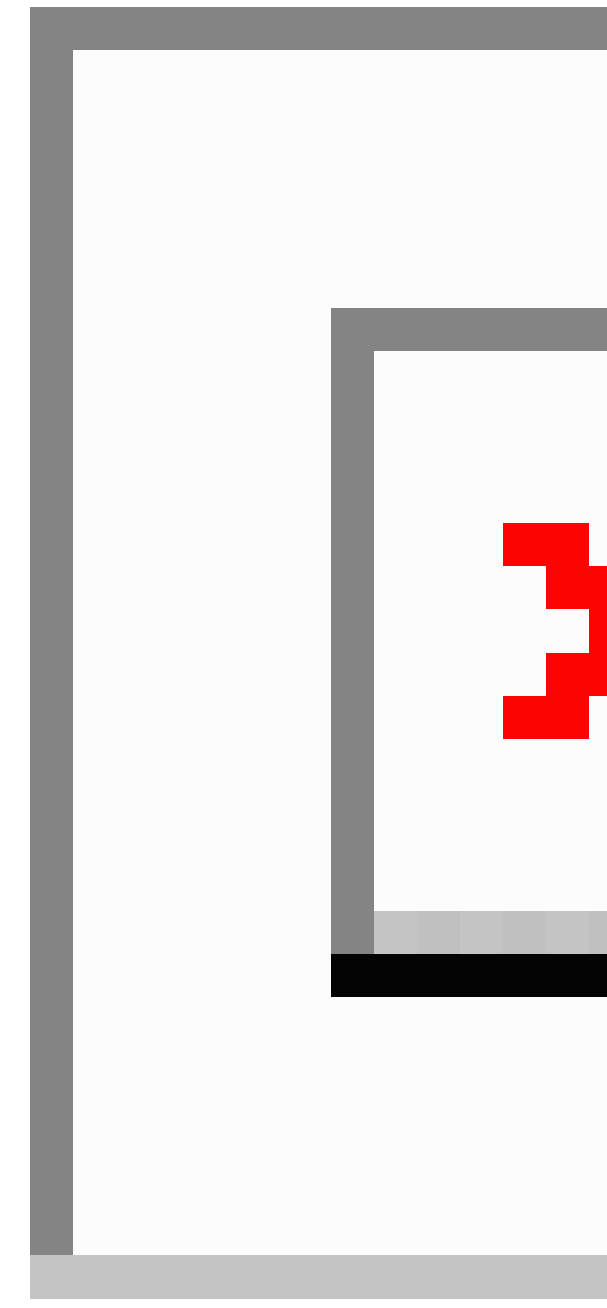
Figure 3. Lifecycle of big data